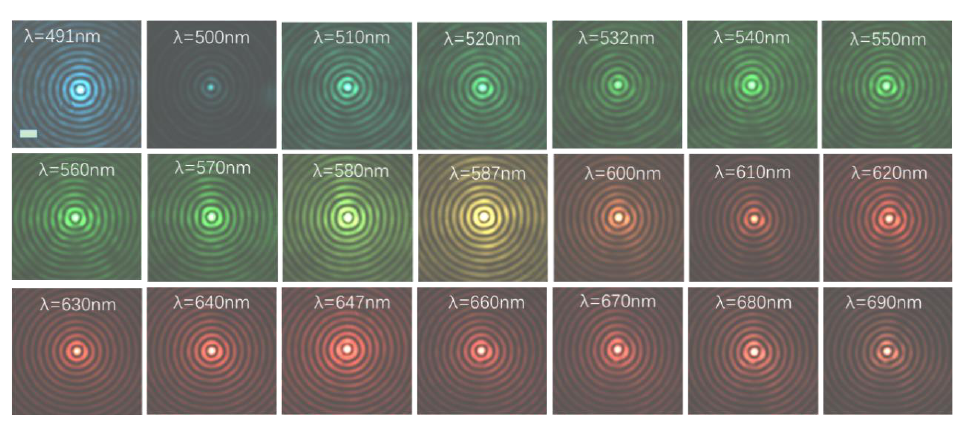
Figure 5. Light field intensity profiles on the transverse cross-section of the BB at λ d = 587 nm; ( a ) numerically simulated; ( b ) experimentally recorded; ( c ) intensity profiles of ( a ) and ( b ) along the x - axis.